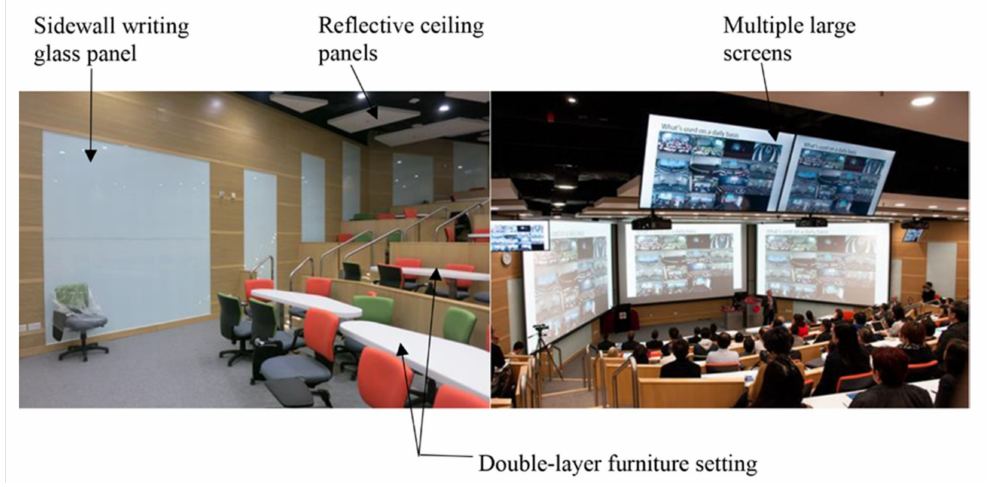
Figure 4. Refitting of classroom